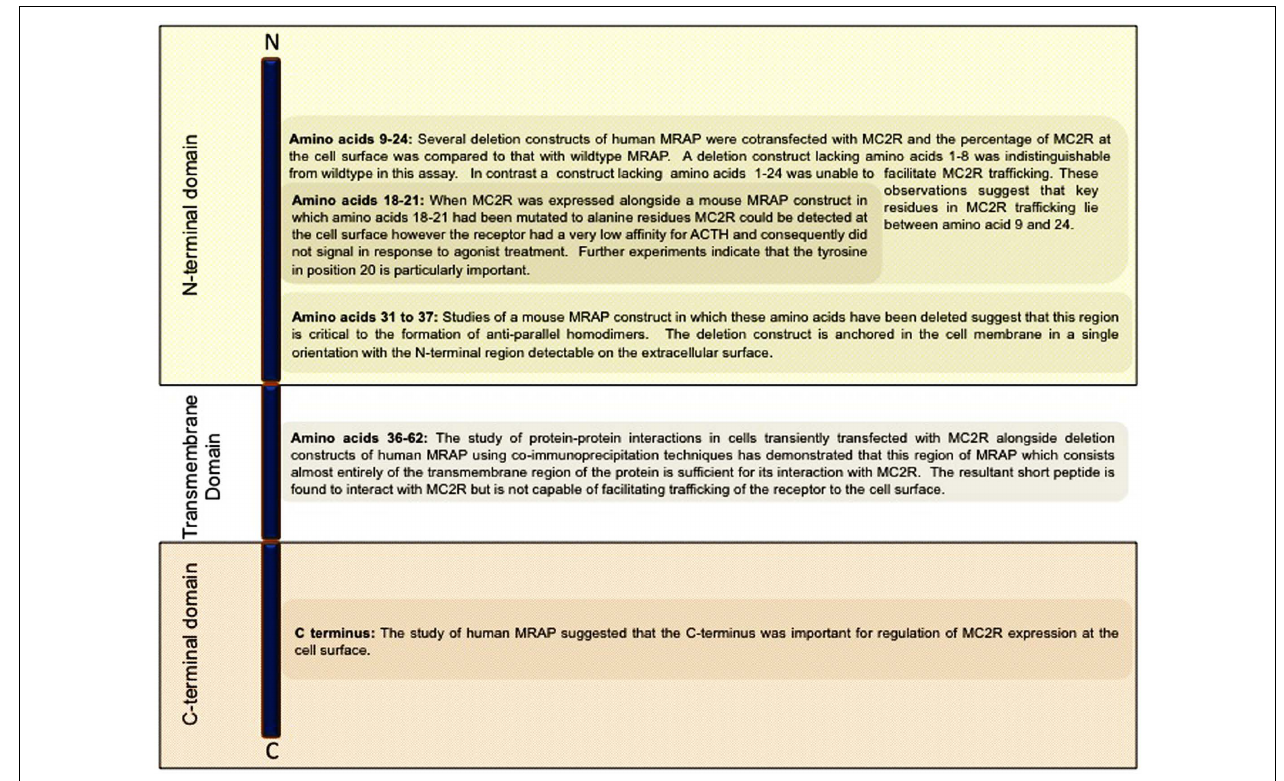
FIGURE 1 | Schematic representation of the domain structure of MRAP highlighting regions of functional significance in MRAP dimerization and in its interaction with MC2R (Sebag and Hinkle, 2009b;Webb etal.,